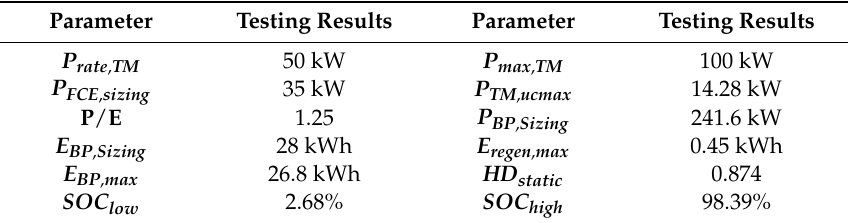
Table 3. Testing results of the first round based on the testing process in Figure